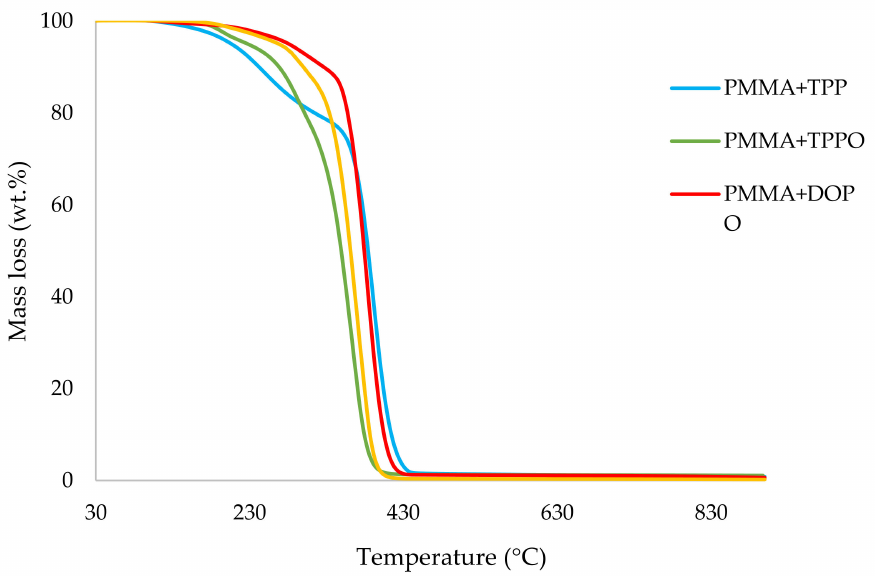
Figure 1. An overlay of the TGA curves of the PMMA-based materials with solid additives, at 10 ◦ C min − 1 .